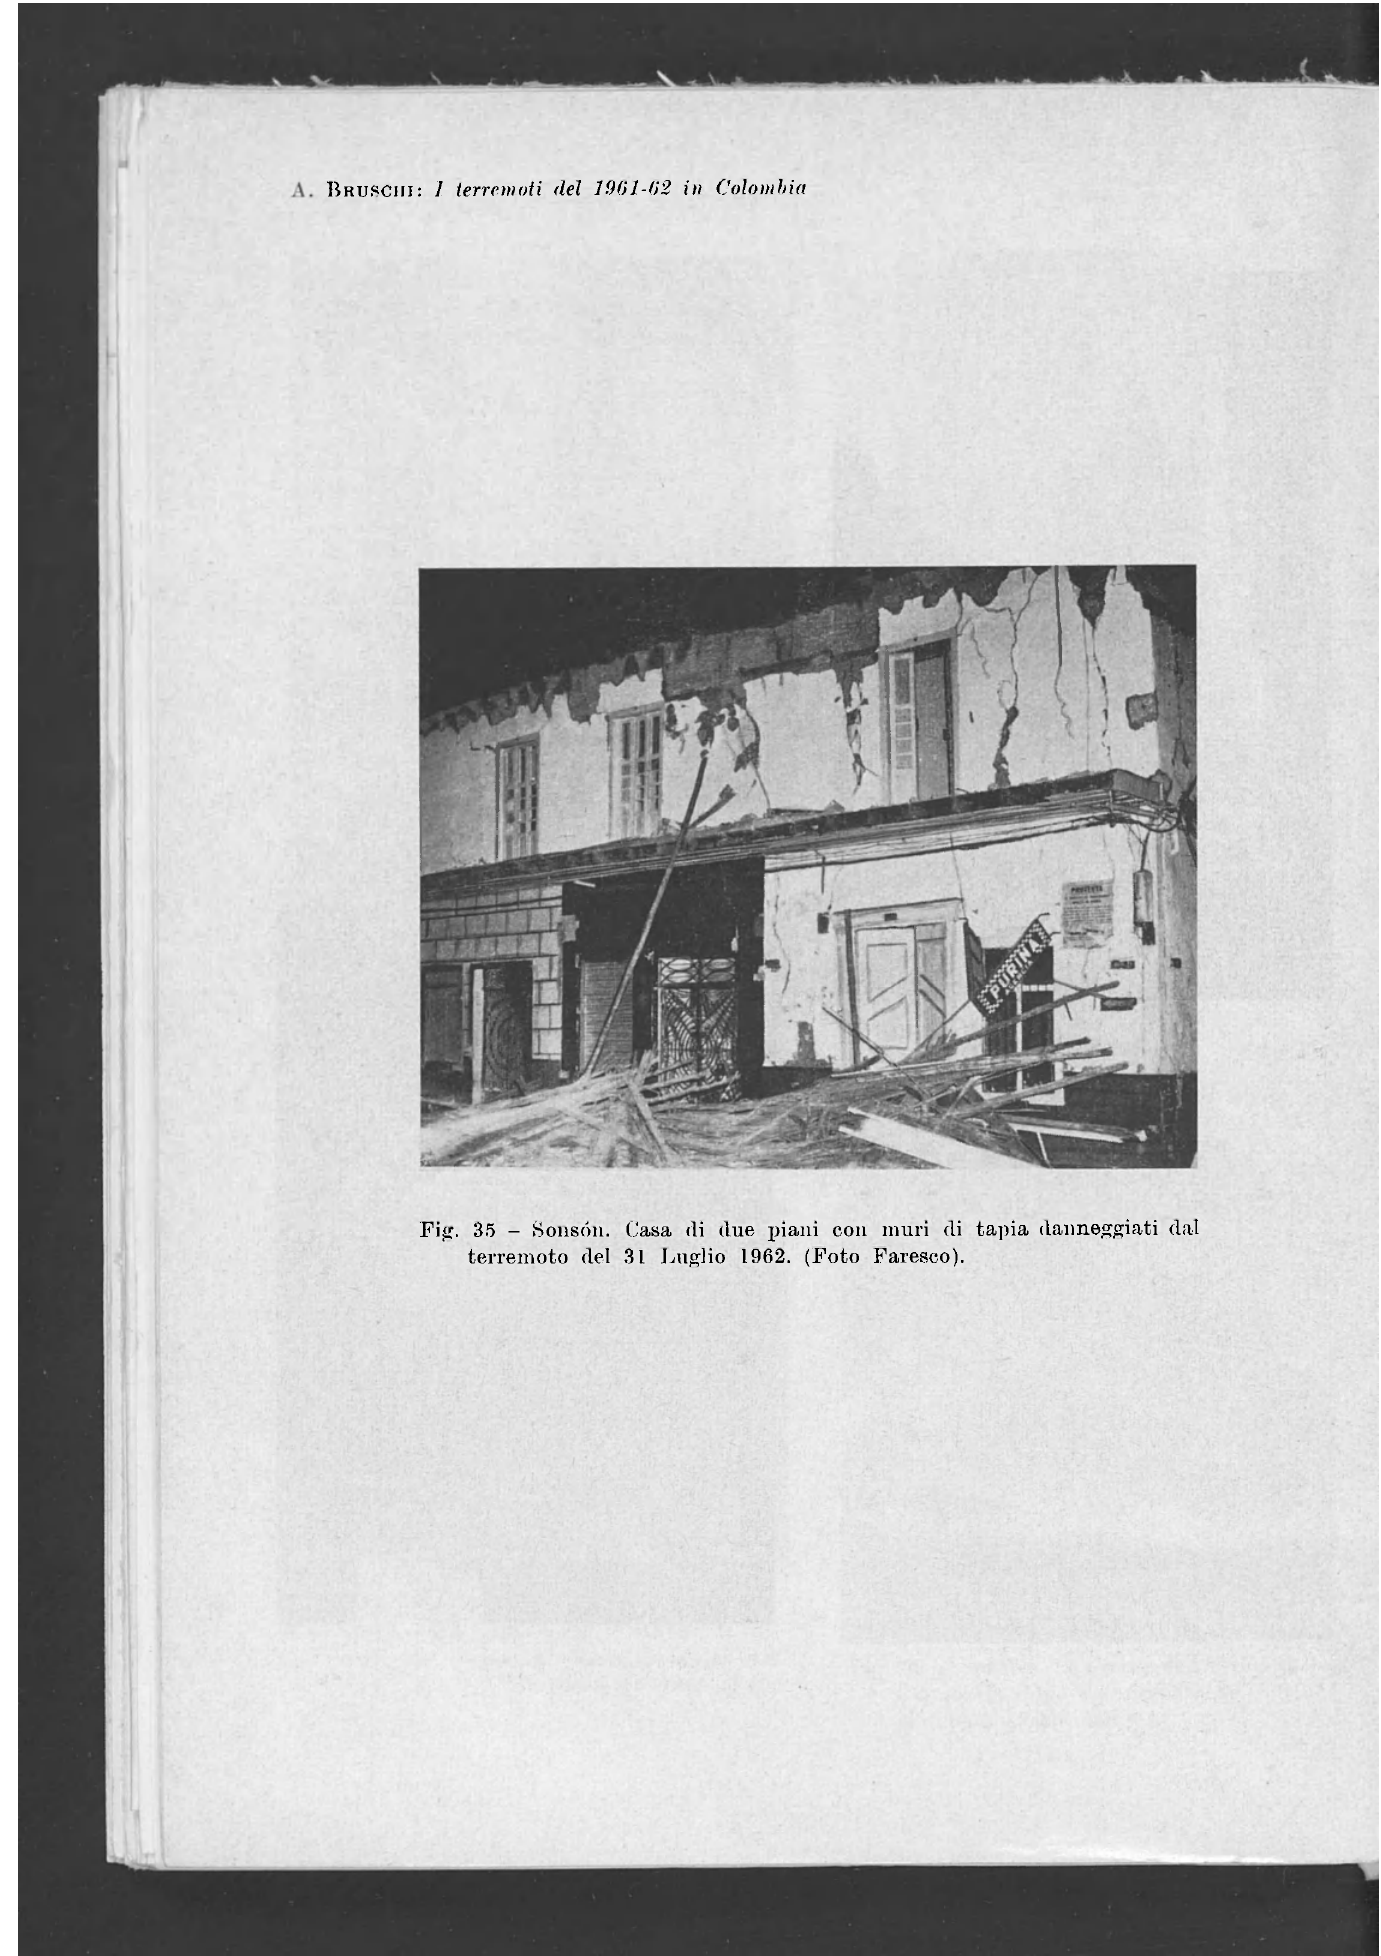
Fig. 35 - Sonsón. Casa (li due piani con muri di tapia danneggiati dal terremoto del 31 Luglio 1962. (Foto